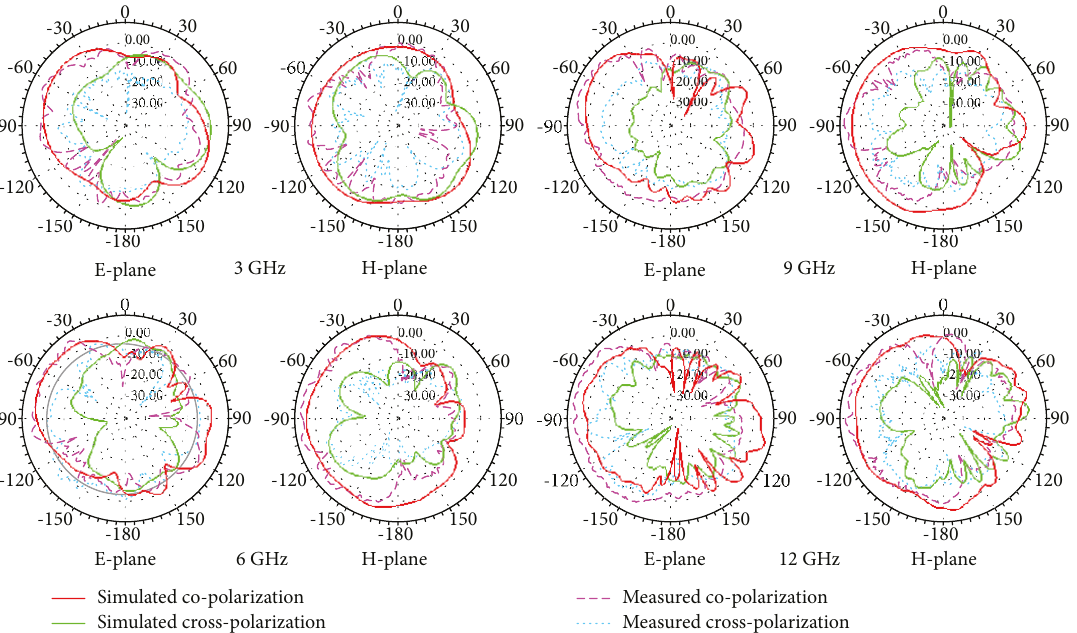
Figure 9: Simulated and measured far- fi eld E-plane and H-plane radiation patterns at several elected frequencies for the low-pro fi le wideband log-period monopole end- fi re antenna.